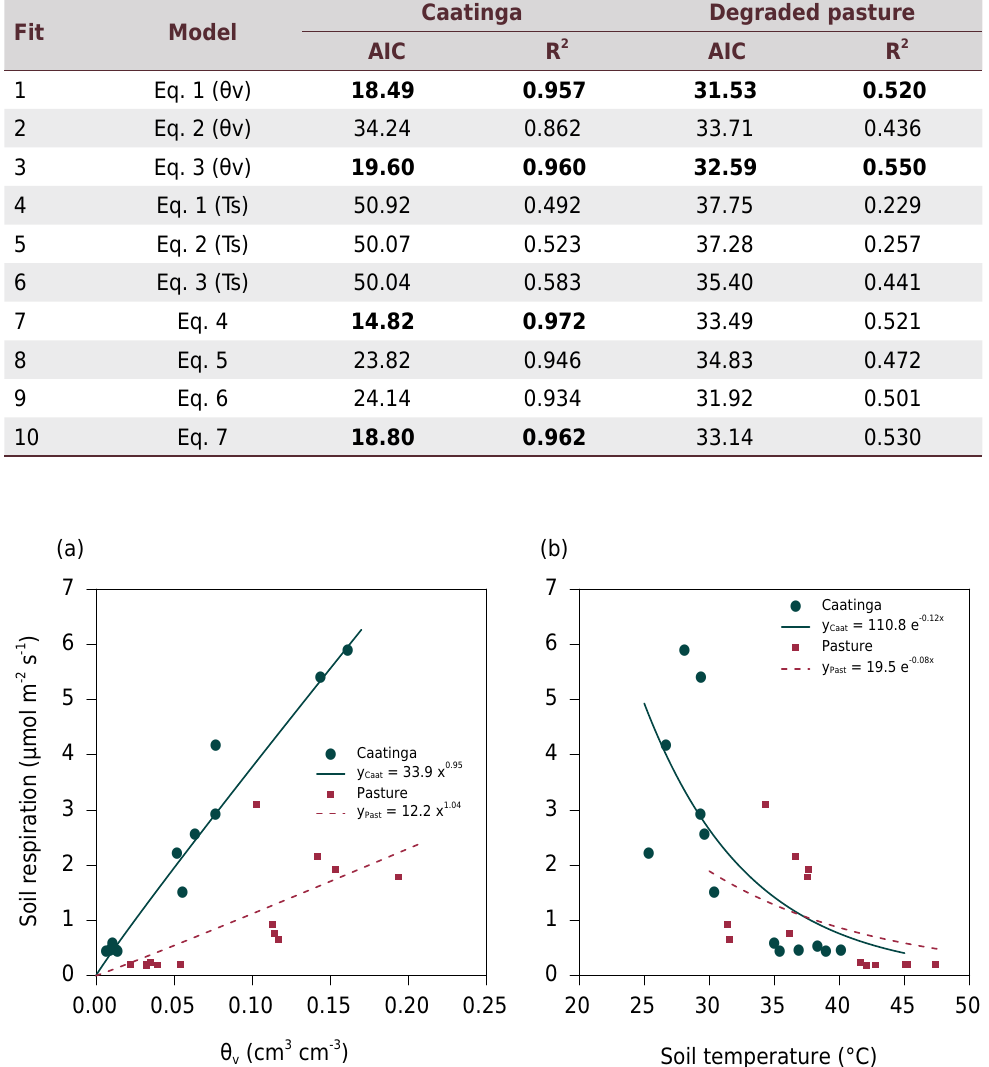
Figure 5. Relationship between soil respiration and soil moisture (a) and soil temperature (b) in Caatinga and degraded